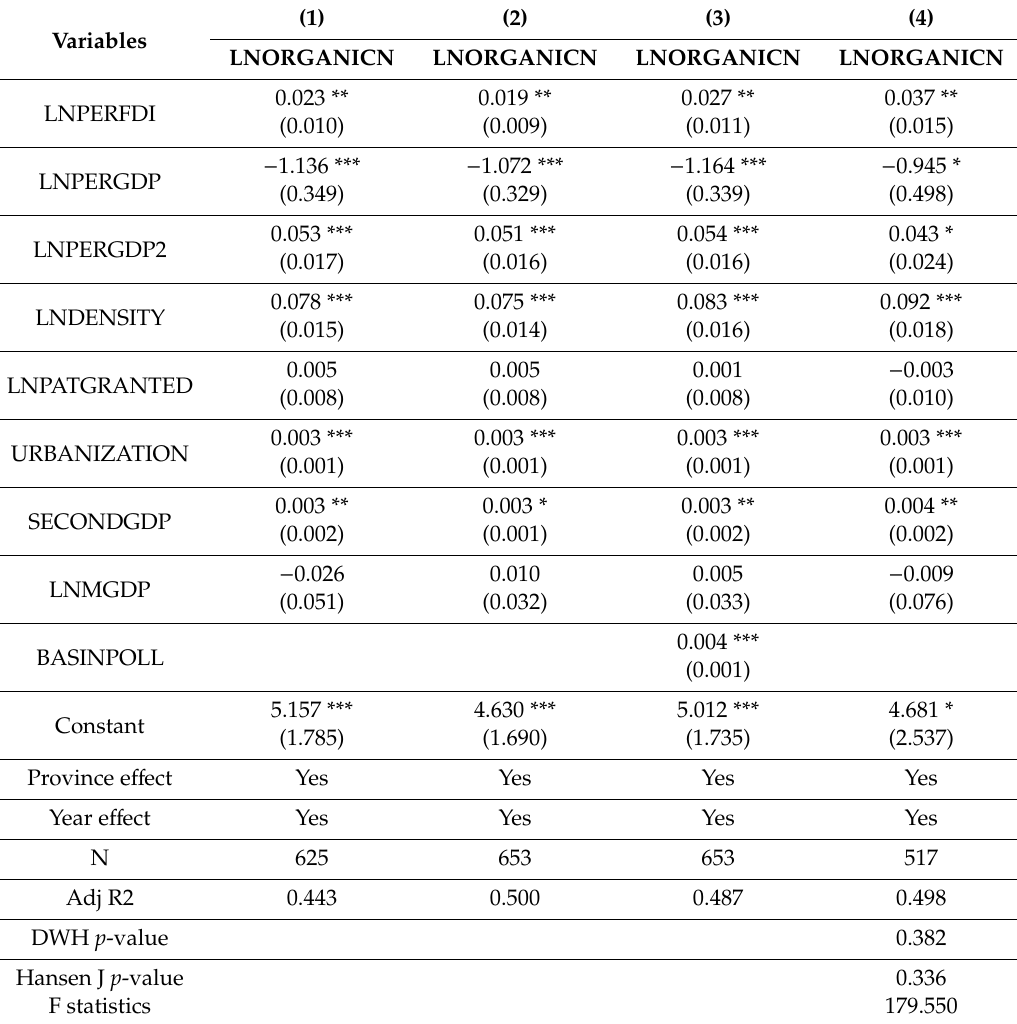
Table 4. Results of other robustness